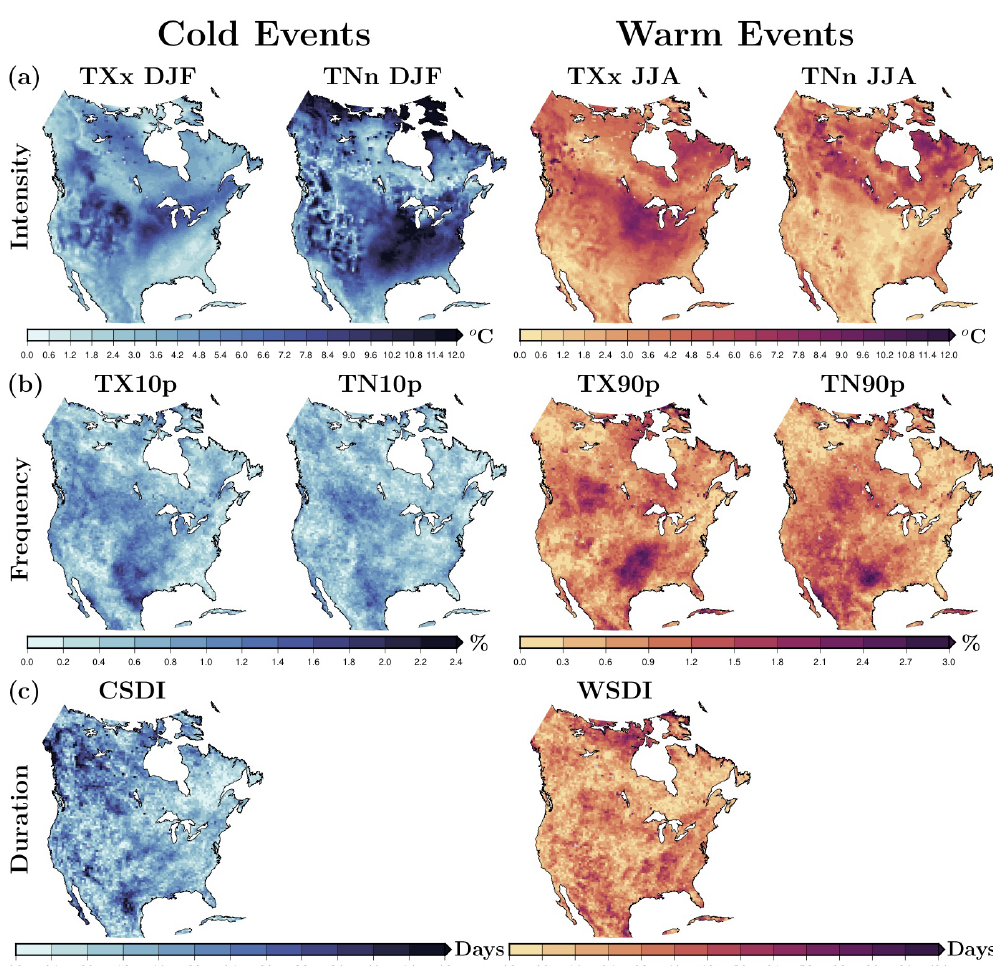
Figure 7. Inter-model range across three CORDEX simulations (i.e., difference between the highest value and the lowest value of the three CORDEX simulations at each grid cell) of extreme indices associated with intensity (a) , frequency (b) and duration (c) of cold and warm extreme temperature events (Table 2). The range across simulations is computed using the mean of each index from 1980 to 2012 for each